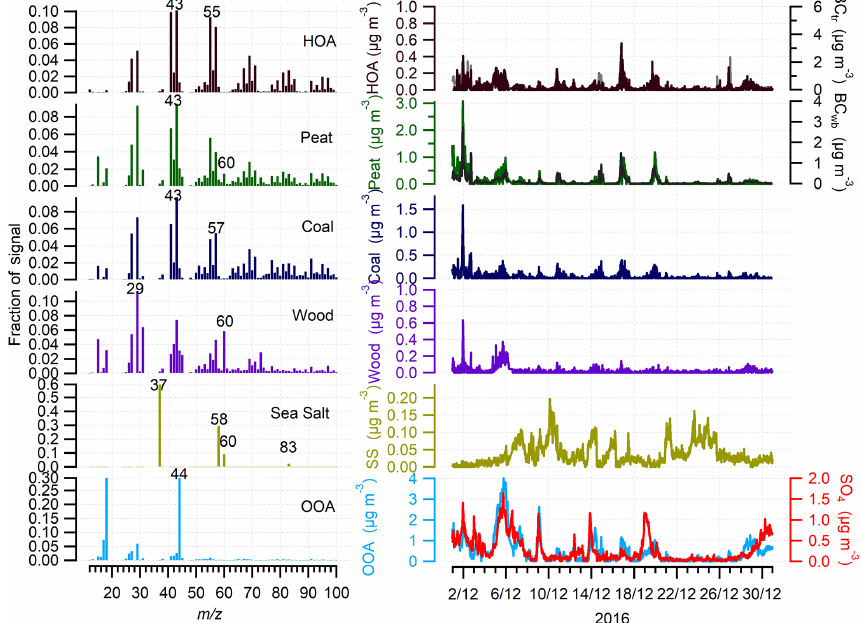
Figure 4. Profiles and time series of HOA, peat, coal, wood, sea salt, and oxygenated OA (OOA) at the rural site of Carnsore Point in December 2016. The time series of BC tr , BC wb , and sulfate (SO 4 ) were also included to support OA source